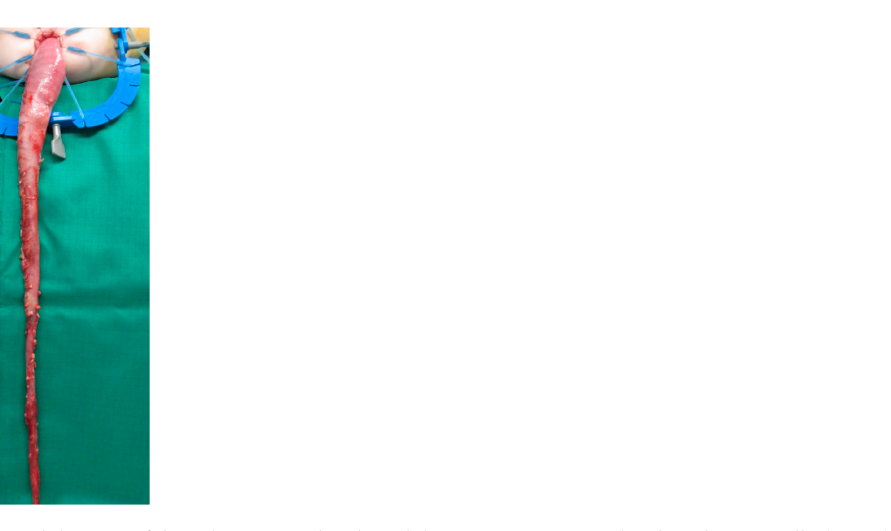
Figure 4. Umbilical camera port is placed, giving an excellent abdominal view ( A ). The transition zone (arrow) is visible now ( B ). Full-thickness dissection is continued by transanal instrumentation entering the transition zone ( C ).